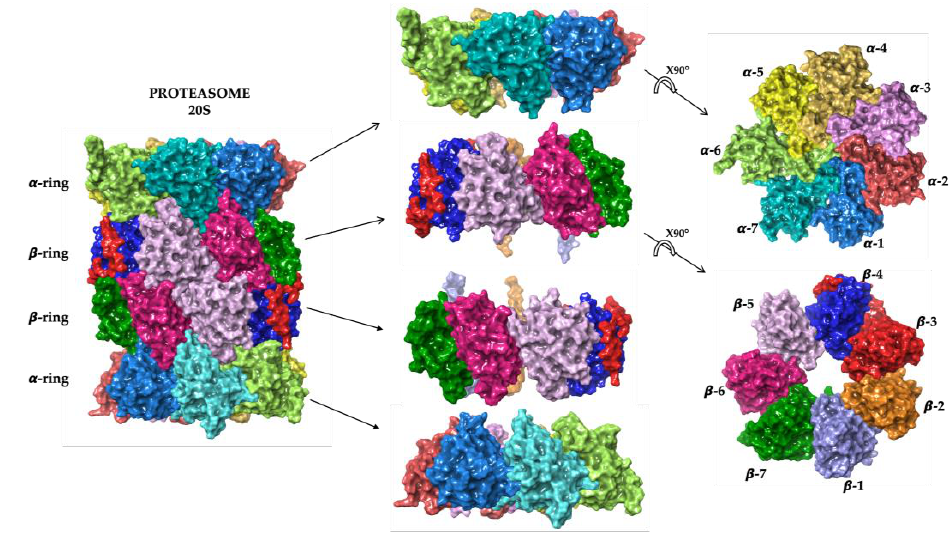
Figure 2. Three-dimensional representation of 20S proteasome structure. Atomic coordinates were obtained from PDB model 5LF7 [33]. The figure was built by means of Maestro graphical interface [30]. Seven α subunits form the two outer rings and serve as the gates through which proteasome substrates enter, meanwhile the seven β subunits form the inner rings. The passage through the gates formed by the N-termini of the α subunits is the rate-limiting step, and prevents unregulated protein degradation [34].